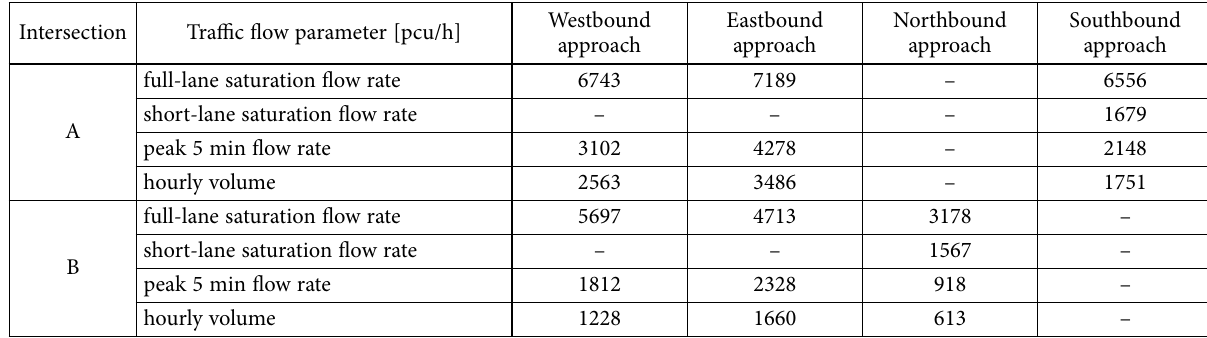
Table 1. Saturation flow rates, peak 5 min flow rates and hourly volumes